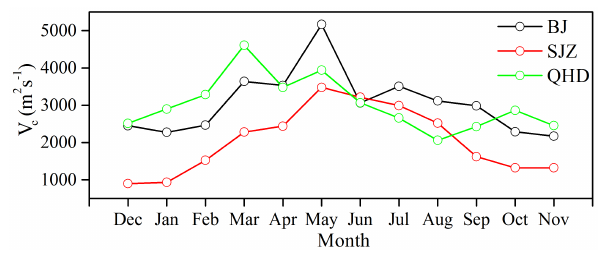
Figure 9. Seasonal variations of V c at the BJ, SJZ and QHD stations from December 2013 to November 2014. The V c is defined as the product of MLH and wind transport (Nair et al., 2007) (Eq. 2). With a larger V c , strong dissipation potential